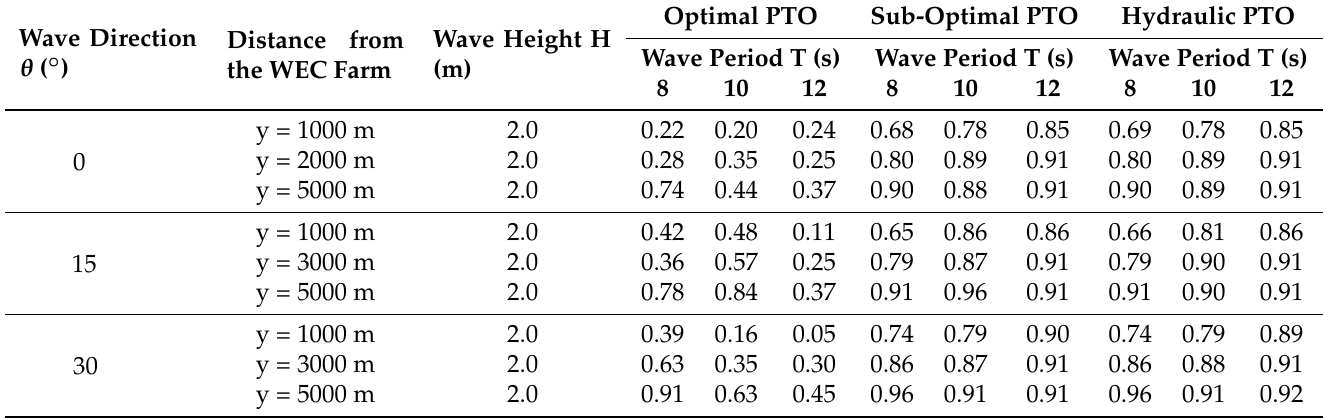
Table 6. K d disturbance coefficient for a farm of 21 OSWECs for a linear optimal, a linear sub-optimal and a hydraulic